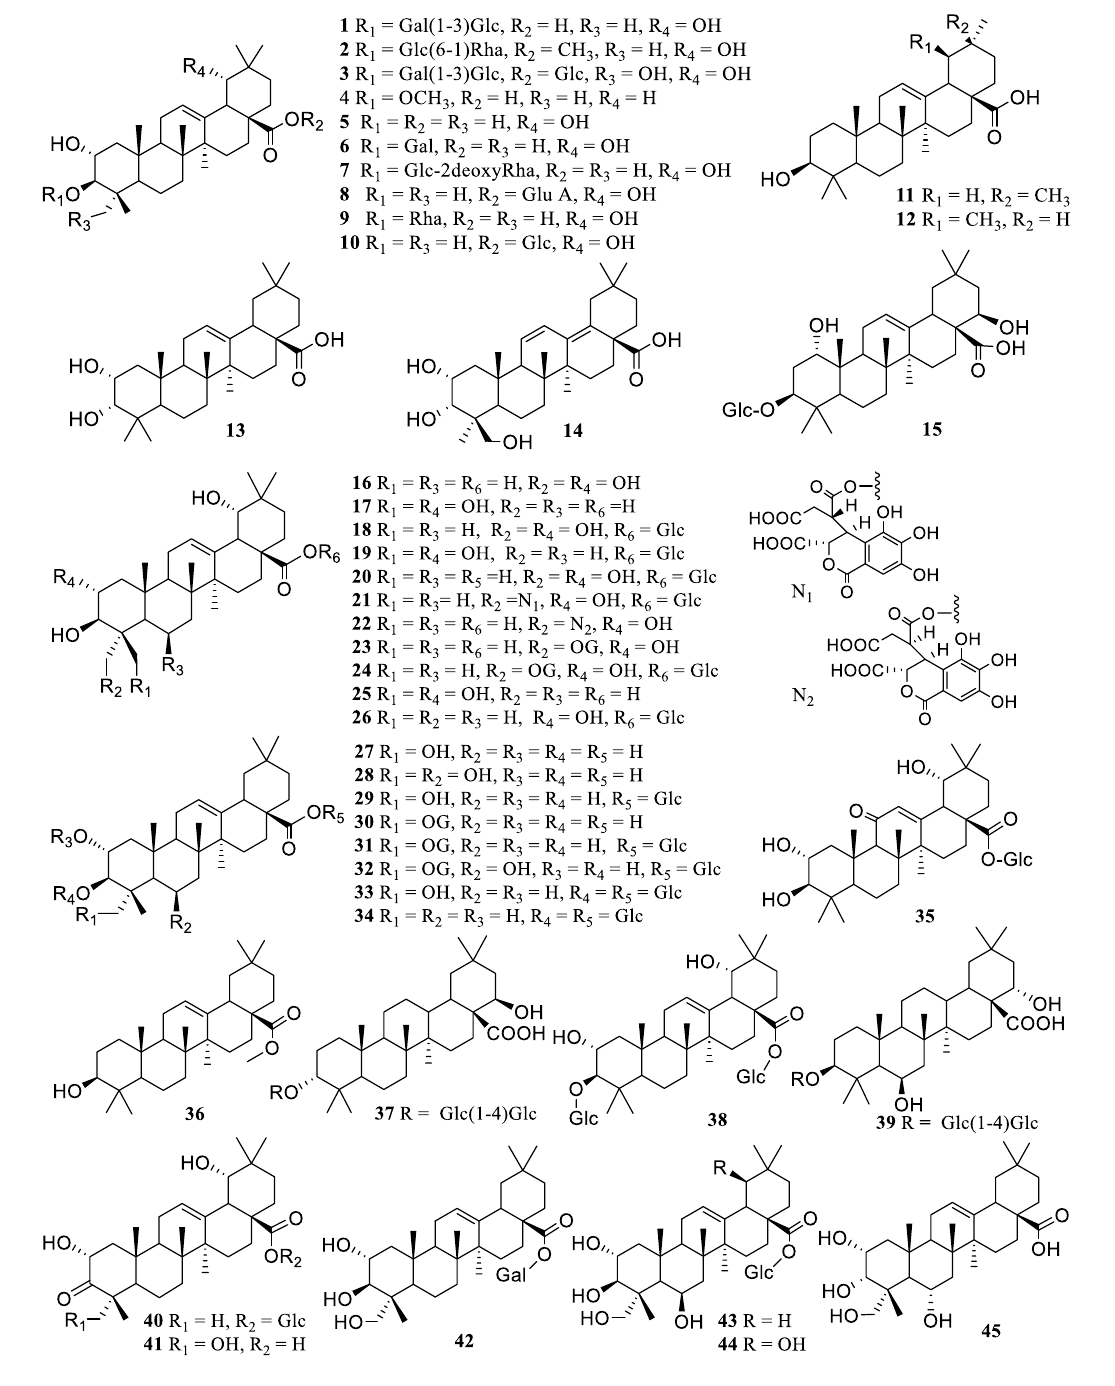
Fig. 1 The structures of terpenoids zone diameters (IZDs) of 17.2 to 10.0 mm, compared to gentamicin (IZD = 21.8–10 mm). The results supported the efficacy of the extracts in the folkloric treatment of burns wounds, bronchitis and dysentery, respectively [42]. Anti- bacterial tests on Mycobacterium smegmatis ATCC 14468 showed that methanol extract of T. sambesiaca roots and 1 3